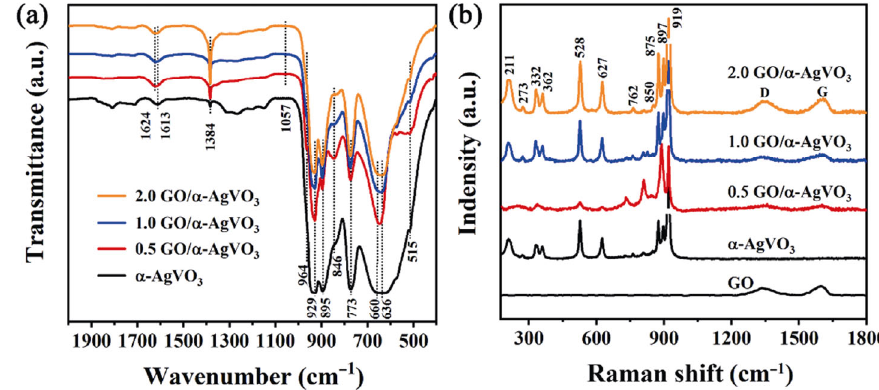
Fig. 6 (a) FTIR spectra and (b) Raman spectra of α -AgVO 3 and GO/ α -AgVO 3 nanocomposites with different GO contents (0.5, 1.0, and 2.0